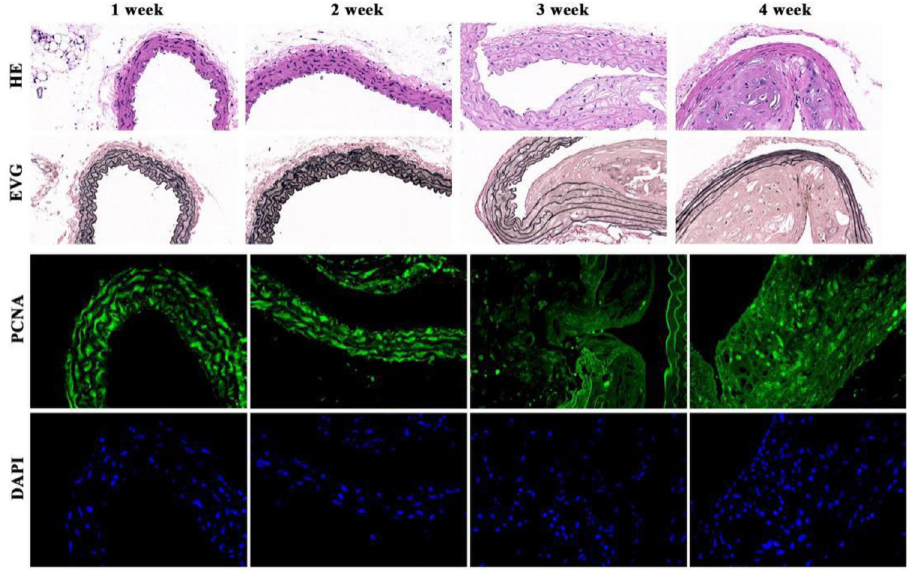
Fig 1. Changes of vascular intima thickness and elastic fiber morphology of rabbits with diabetic hindlimb vascular lesions 1–4 weeks after modeling (x400). First line: HE staining under ordinary light microscope showed that the atherosclerotic plaques gradually formed in the arterial wall and the lumen narrowed with time. Second line: EVG staining under ordinary light microscope showed that atherosclerotic plaques gradually formed in the arterial wall and the lumen narrowed with time. Third line: Fluorescence electron microscopy showed that PCNA positive cells in the arterial wall of rabbits increased and the arterial wall thickened gradually with time. Forth line: DAPI staining under fluorescence electron microscope showed that the proliferative cells in the arterial wall increased and the arterial wall thickened with time. HE: hematoxylin-eosin; EVG: Elastin Van Gieson; PCNA: proliferating cell nuclear antigen; DAPI: 4’,6-diamidino-2-phenylindole.